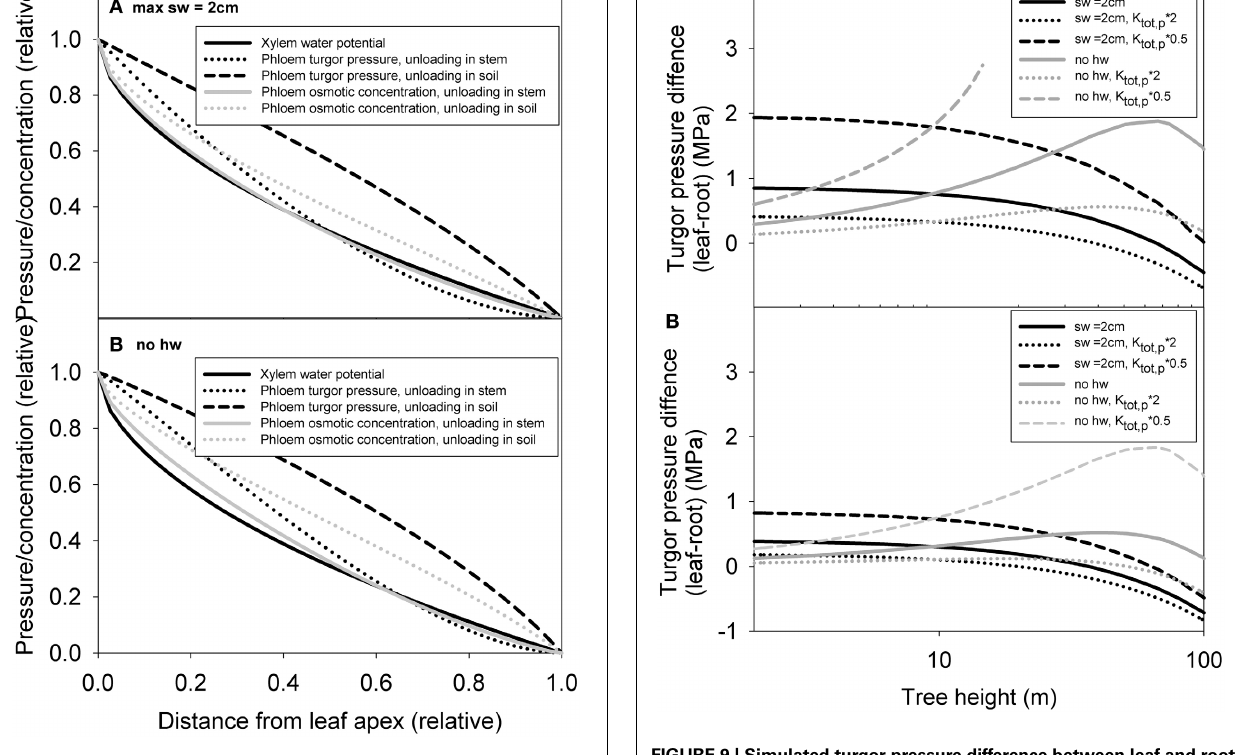
FIGURE 8 | Simulated xylem water potential, phloem turgor pressure and phloem osmotic concentration axial profiles for cases of phloem unloading in sink and phloem unloading along the stem for pine with an assumption of maximum sapwood depth of 2cm (A) and no heartwood formation (B).